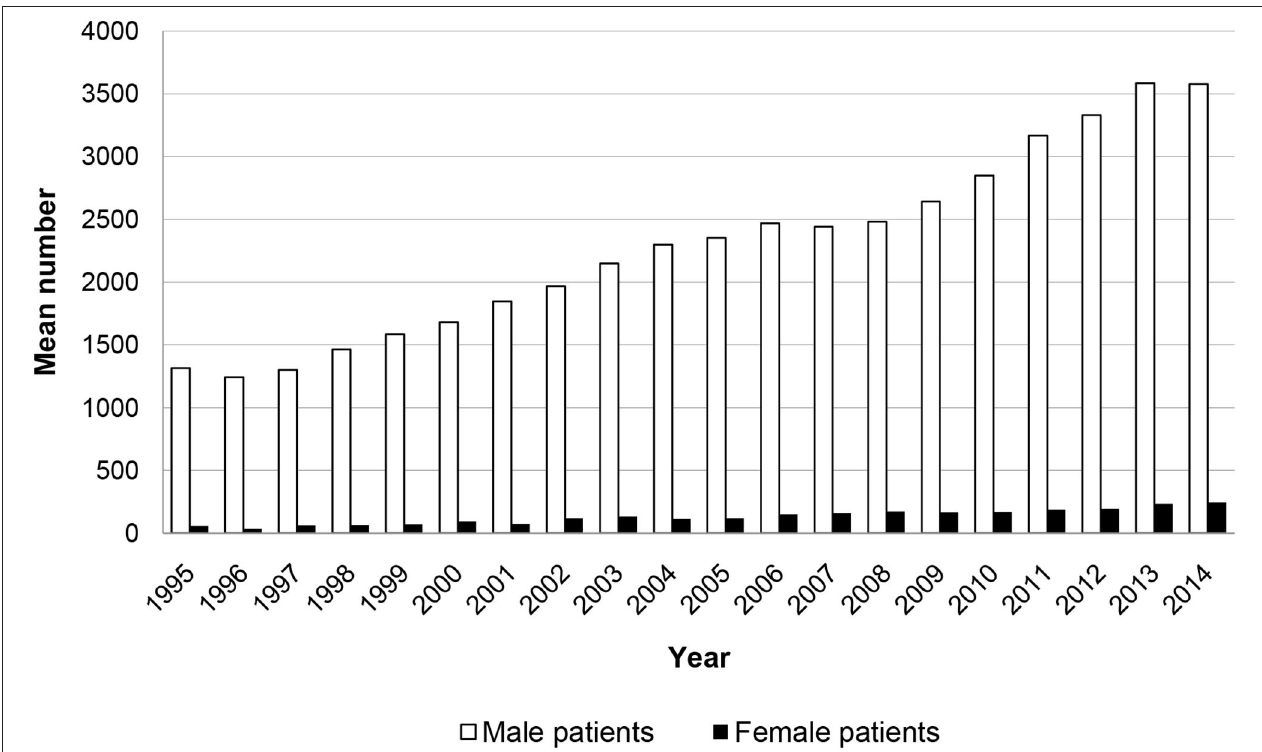
explained against the background of social role